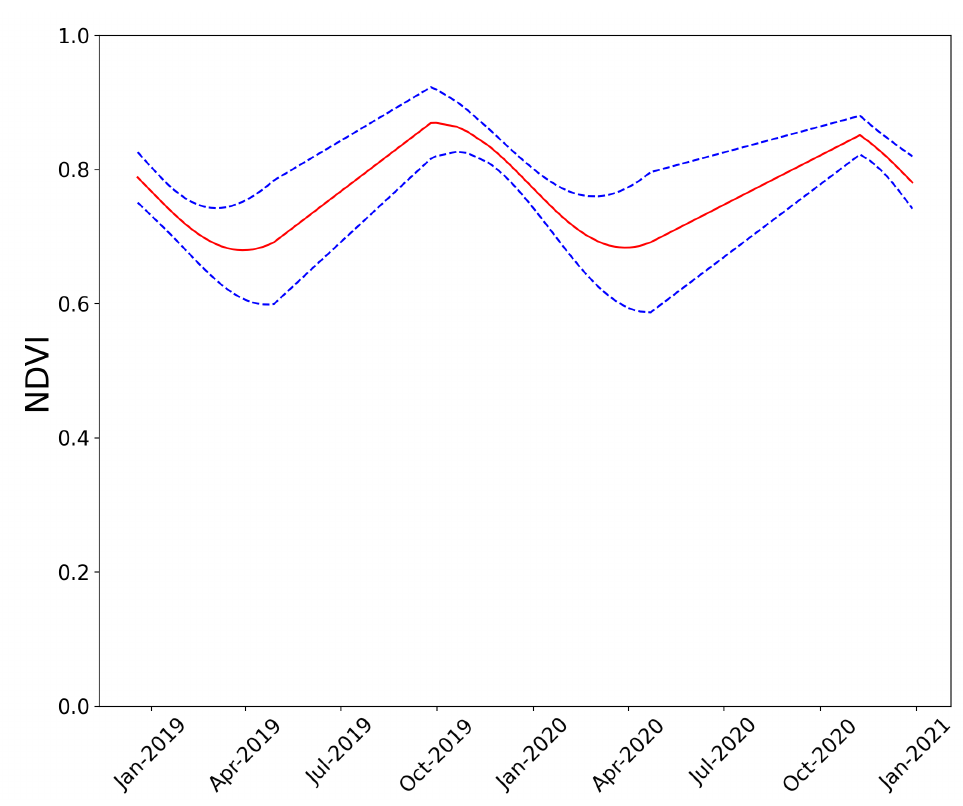
Figure 8. Time series of NDVI in 2019 and 2020. The red line represents the mean value (50th percentile), the upper blue dashed line represents the 84th percentile and the lower blue dashed line the 16th